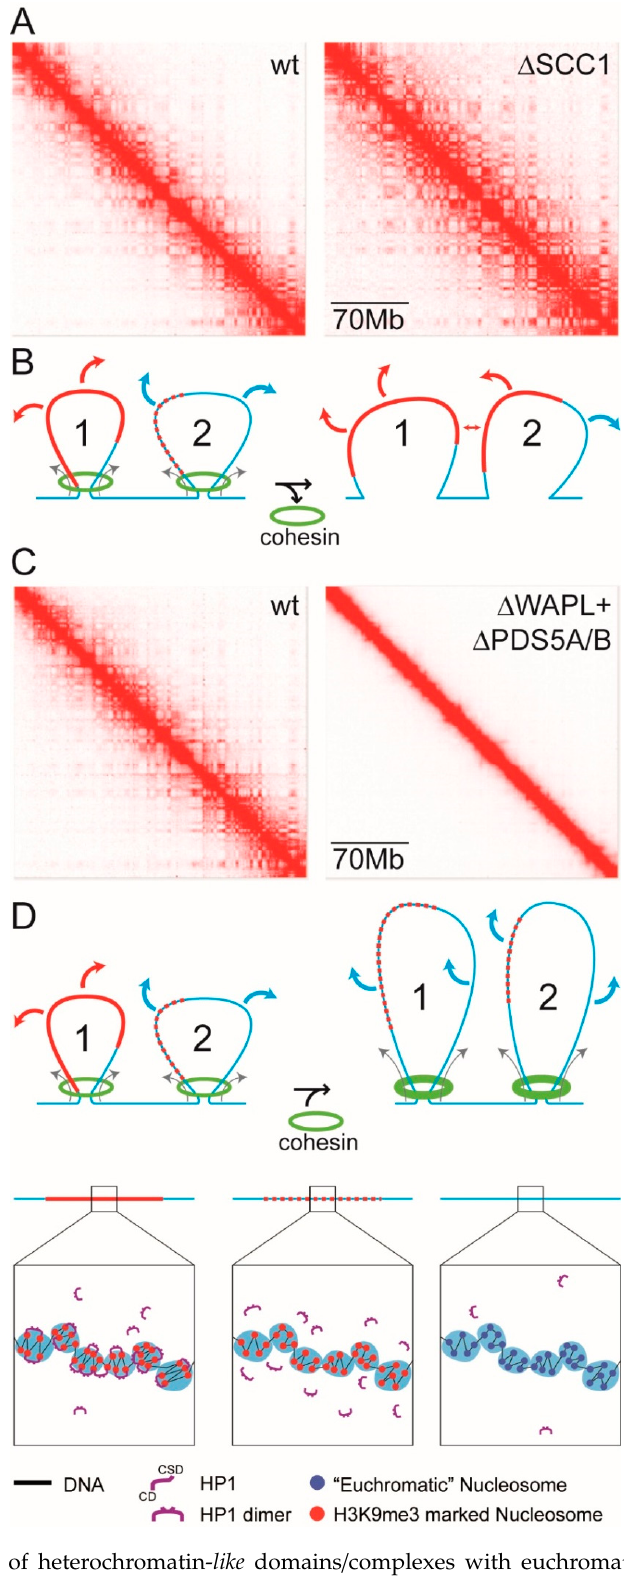
Figure 5. Mixing of heterochromatin -like domains/complexes with euchromatin by modulating chromatin-associated cohesin activity. ( A ) Hi-C maps for wt and SCC1 depleted cells at low resolution (70 Mb) to show the effect of cohesin depletion on compartmentalisation. The Hi-C map